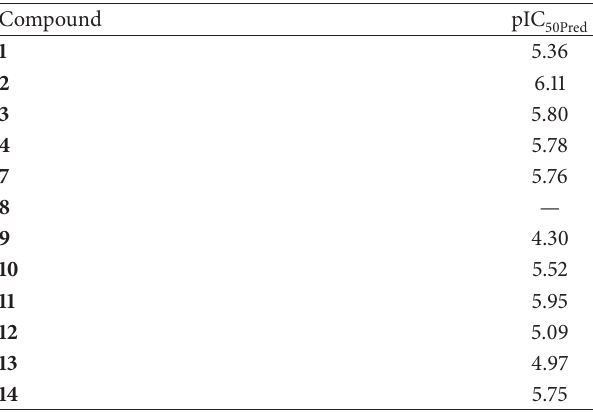
values for compounds 1 – 14 Pred